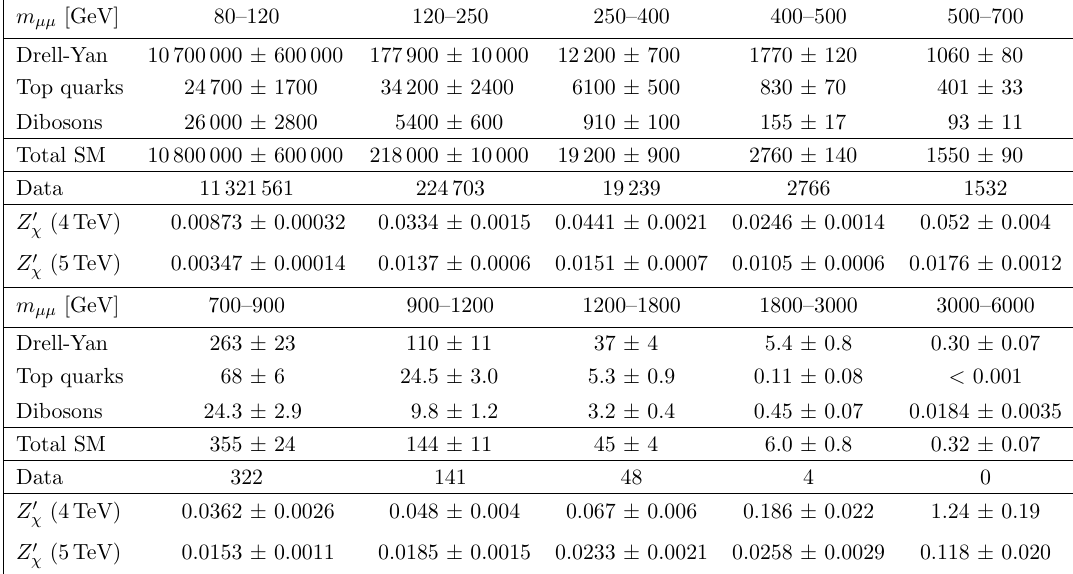
Table 4 . Expected and observed event yields in the dimuon channel in di(cid:11)erent dilepton mass intervals. The quoted errors correspond to the combined statistical, theoretical, and experimental systematic uncertainties. Expected event yields are reported for the Z 0 the pole mass. All numbers shown are obtained before the marginalisation